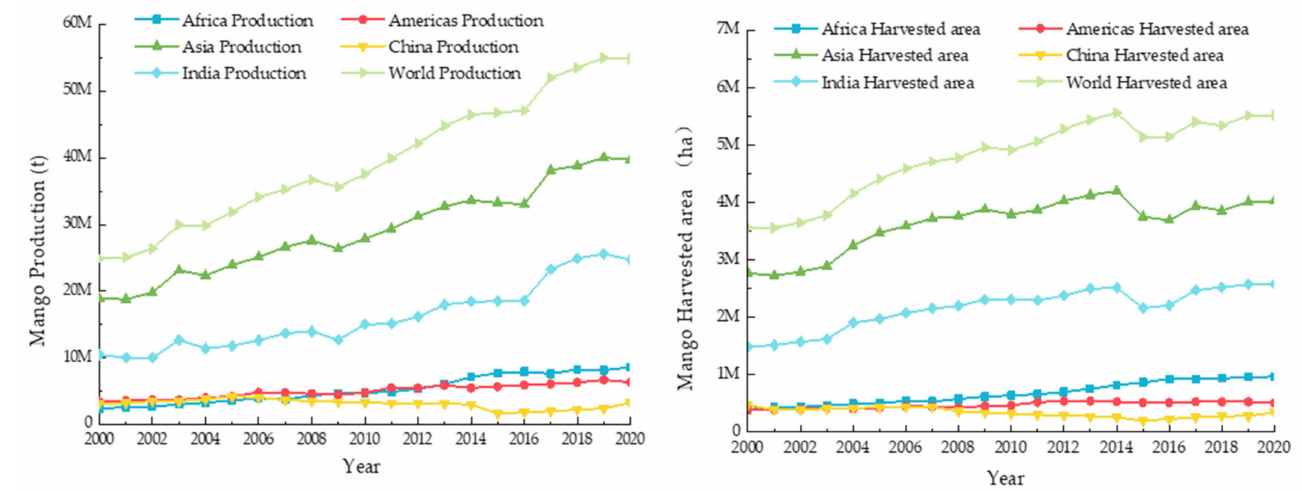
Figure 1. Mango planting area and yield in the world from 2000 to 2020